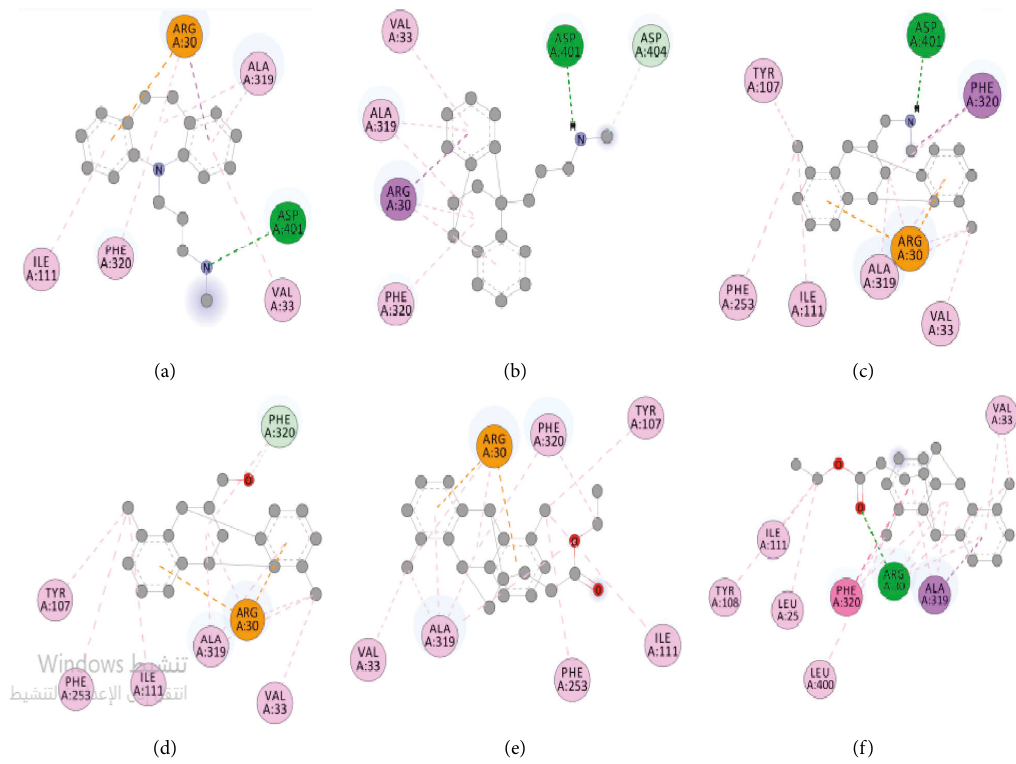
Figure 7: Potential energy scan profiles for the conformational interconversion of the conformers 2-C1 , 2-C2, and 2-C3